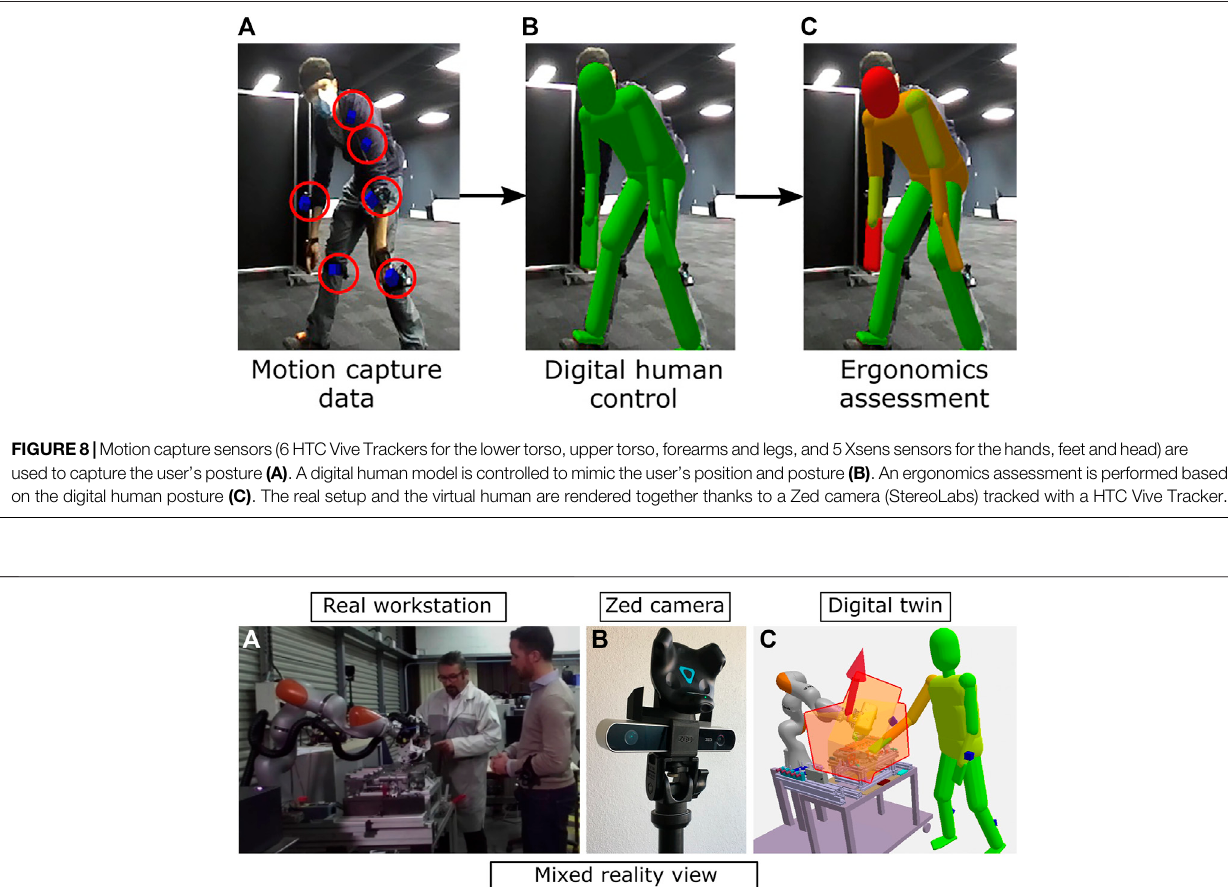
Frontiers in Virtual Reality |